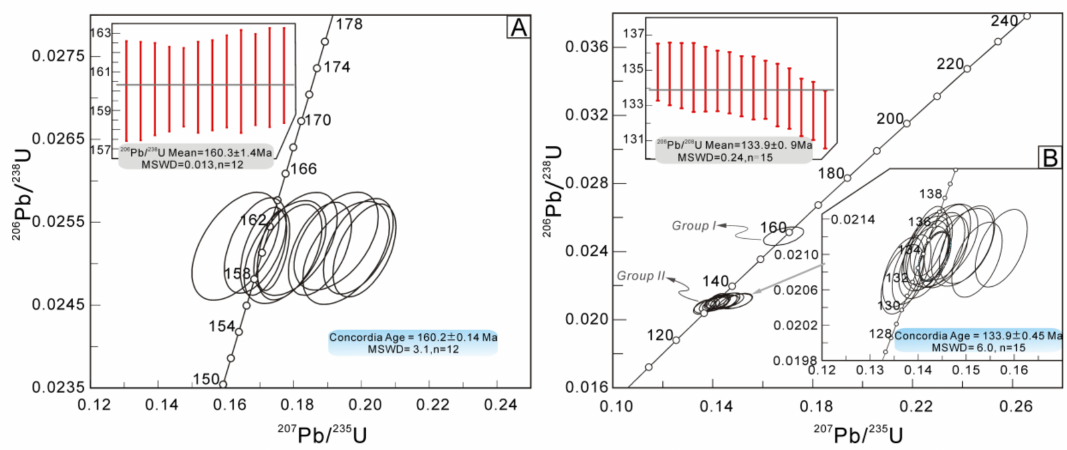
Figure 7. ( A ) Concordia diagrams of the zircon U–Pb ages for the quartz porphyry; ( B ) concordia diagrams of the zircon U–Pb ages for the andesite